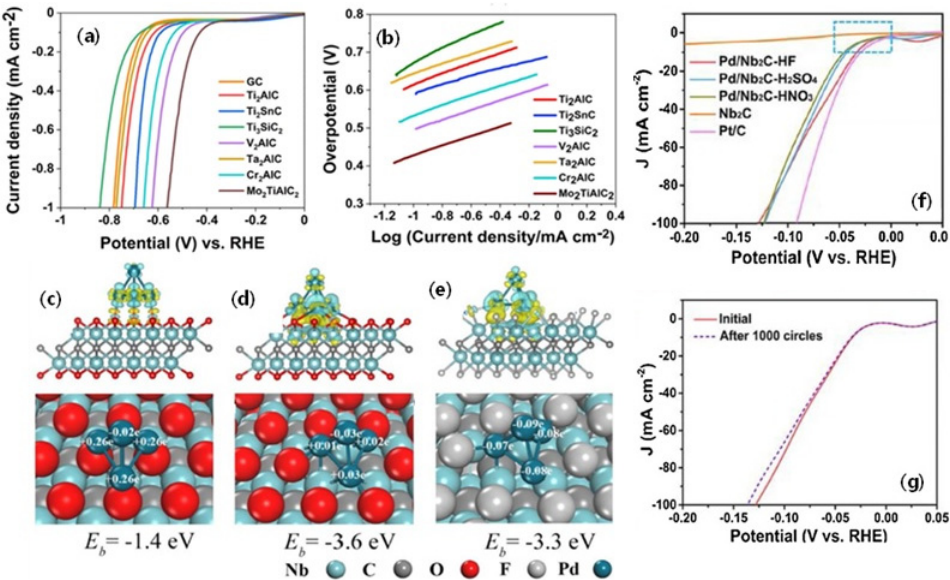
Figure 6. ( a ) Linear sweep voltammograms of GC, MAX phases at a scan rate of 5 mV s − 1 . ( b ) Tafel plots of MAX phases (Adapted from Ref. [74], Open Access). Charge density differences, binding energies, and Bader charges of Pd 4 cluster supported with O-terminated Nb 2 C ( c ), O-terminated Nb 2 C with one O vacancy ( d ), F-terminated Nb 2 C with one F vacancy ( e ), cyan (yellow) isosurfaces indicate depletion (addition) of 0.005e/Å − 3 . The cyan, gray, red, silver, deep-blue spheres represent the Nb, C, O, F and Pd, respectively. (For interpretation of the references to color in this figure legend, the reader is referred to the web version of this article). Electrochemical performance of the supported nano catalysts ( f ) HER polarization curves ( g ) Polarization curves Pd/Nb 2 C-HF before and after 1000 cycles testing (Reprinted with permission from Ref. [76] Copyright, Elsevier).